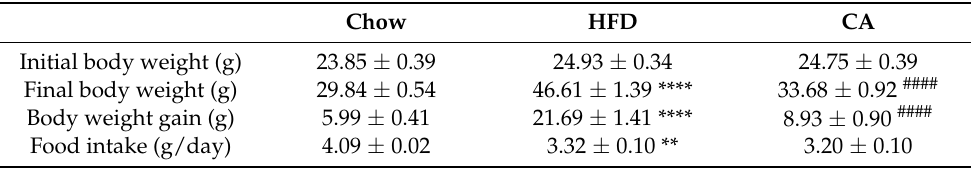
Table 3. Effects of CA on body weight and food intake of HFD-fed mice.